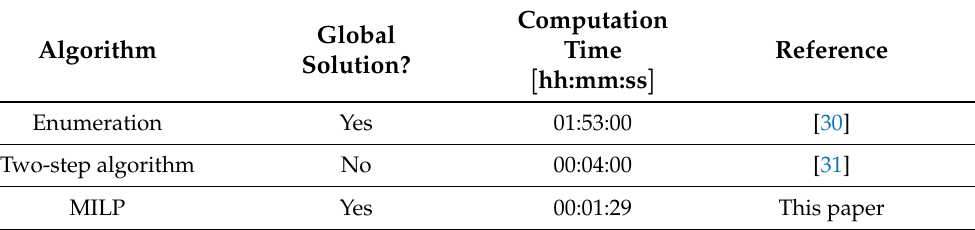
Table 7. Comparison with other